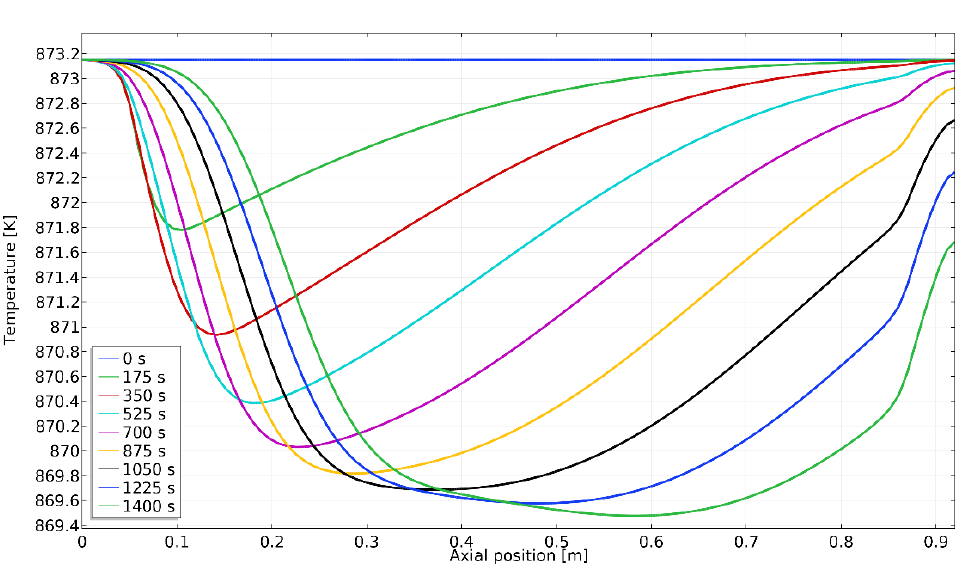
Figure 9. Axial concentration in the fuel reactor at different moments in time during reduction with CO.